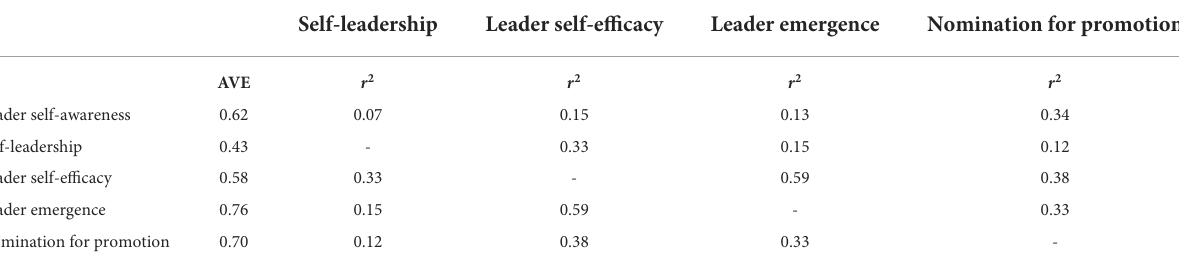
TABLE 3 Discriminant validity in Study 2.